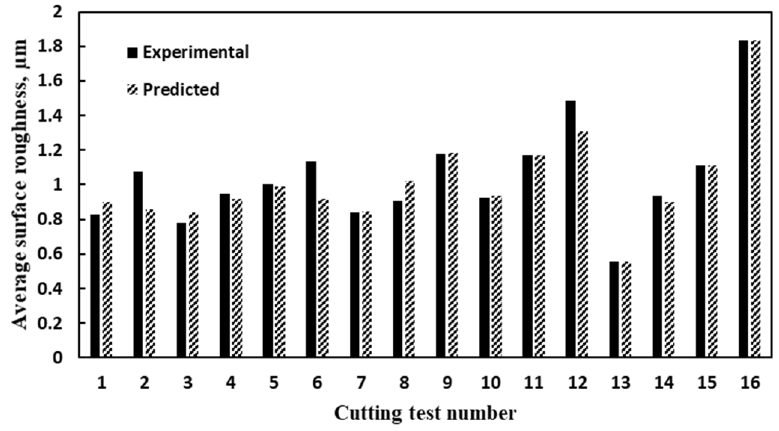
Figure 8. A Comparison between experimental and predicted average surface roughness.